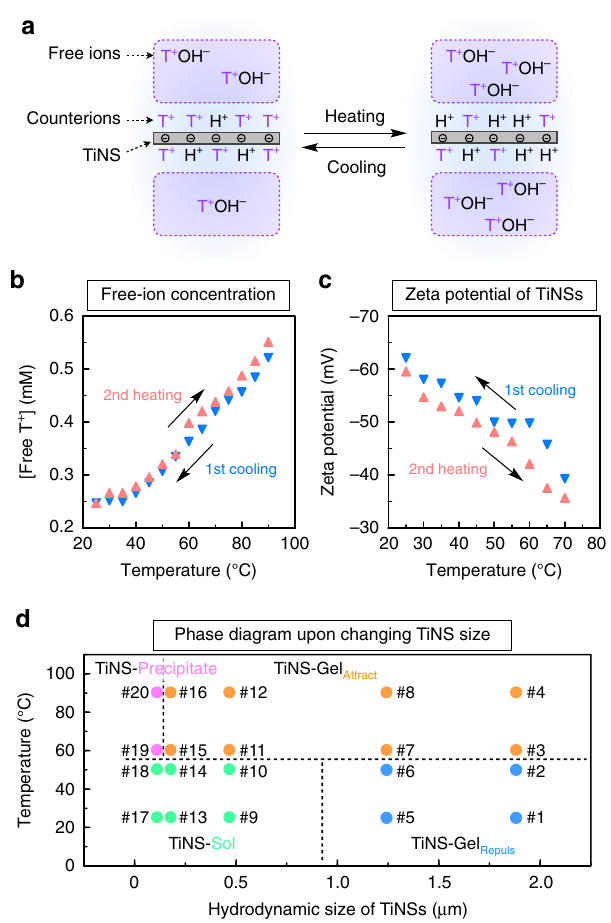
Fig. 6 Mechanism of gel-to-gel transition and phase diagram of TiNS-Gel. a Schematic illustration for the mechanism of tunable electrostatic repulsion of TiNSs. TiNSs carry a lot of surface anions (Ti – O – ) that form ion pairs with tetrabutylammonium countercations (T + ) and protons (H + ). Upon heating, the countercations T + , which are originally trapped by Ti – O – on TiNSs, are replaced with H + from bulk water. This thermally induced T + /H + replacement increases the concentration of free T + ions and causes neutralization of the negative charges on Ti – O – on TiNSs. Consequently, upon heating, the electrostatic repulsion between TiNSs is attenuated. Upon cooling, the opposite changes occur, so that the electrostatic repulsion between TiNSs is recovered. b , c Changes in the concentration of free ions of T + (measured for a 0.1 wt% TiNS dispersion; b ) and surface potential of TiNS (measured for a 0.01 wt% TiNS dispersion; c ) upon thermal scanning. d Thermal phase diagram of TiNSs dispersed in water ([TiNS] = 14 wt%) with systematically changing the hydrodynamic size of